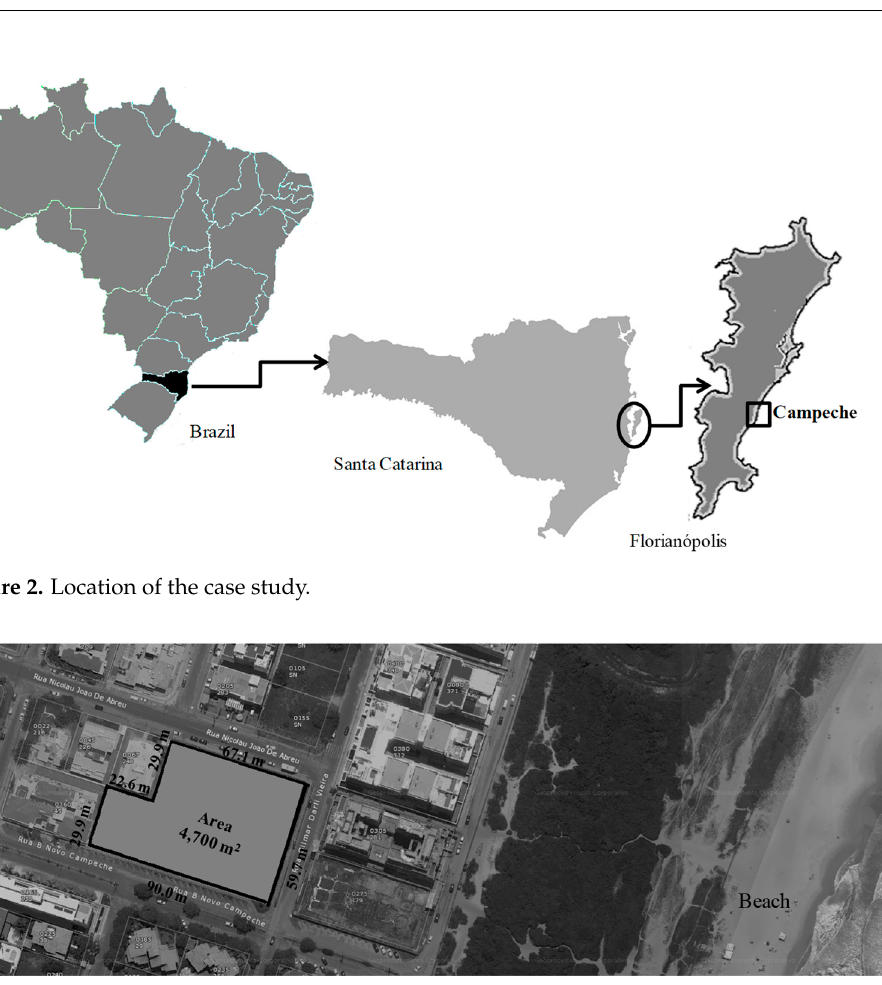
Figure 3. Area chosen for the square (based on [30]).